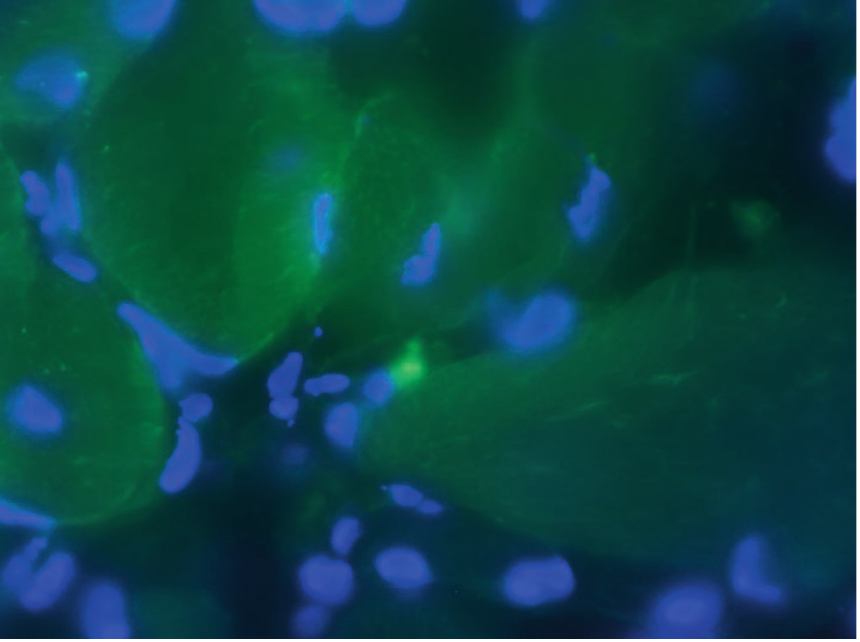
Cryostat section of the maternal scar and muscle tissue of the abdominal wall one week after deliv- ery of pubs who received eGFP+ MSC by in-utero transplantation. Nuclei are stained using DAPI (blue dye). One cell is eGFP positive